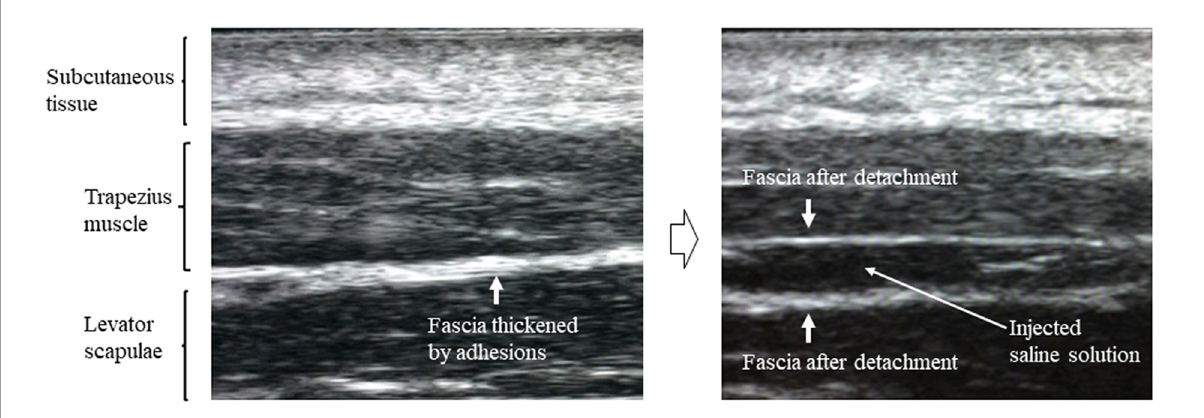
FIGURE1 Ultrasound image showing thickening of the fascia between the levator scapulae and trapezius muscles before hydrodissection and removal of fascia after hydrodissection.